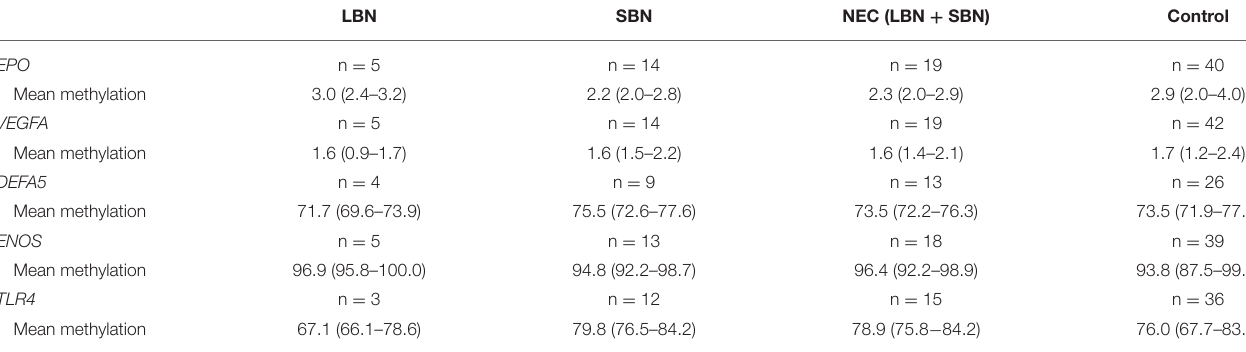
TABLE 3 | Mean DNA methylation prior to NEC